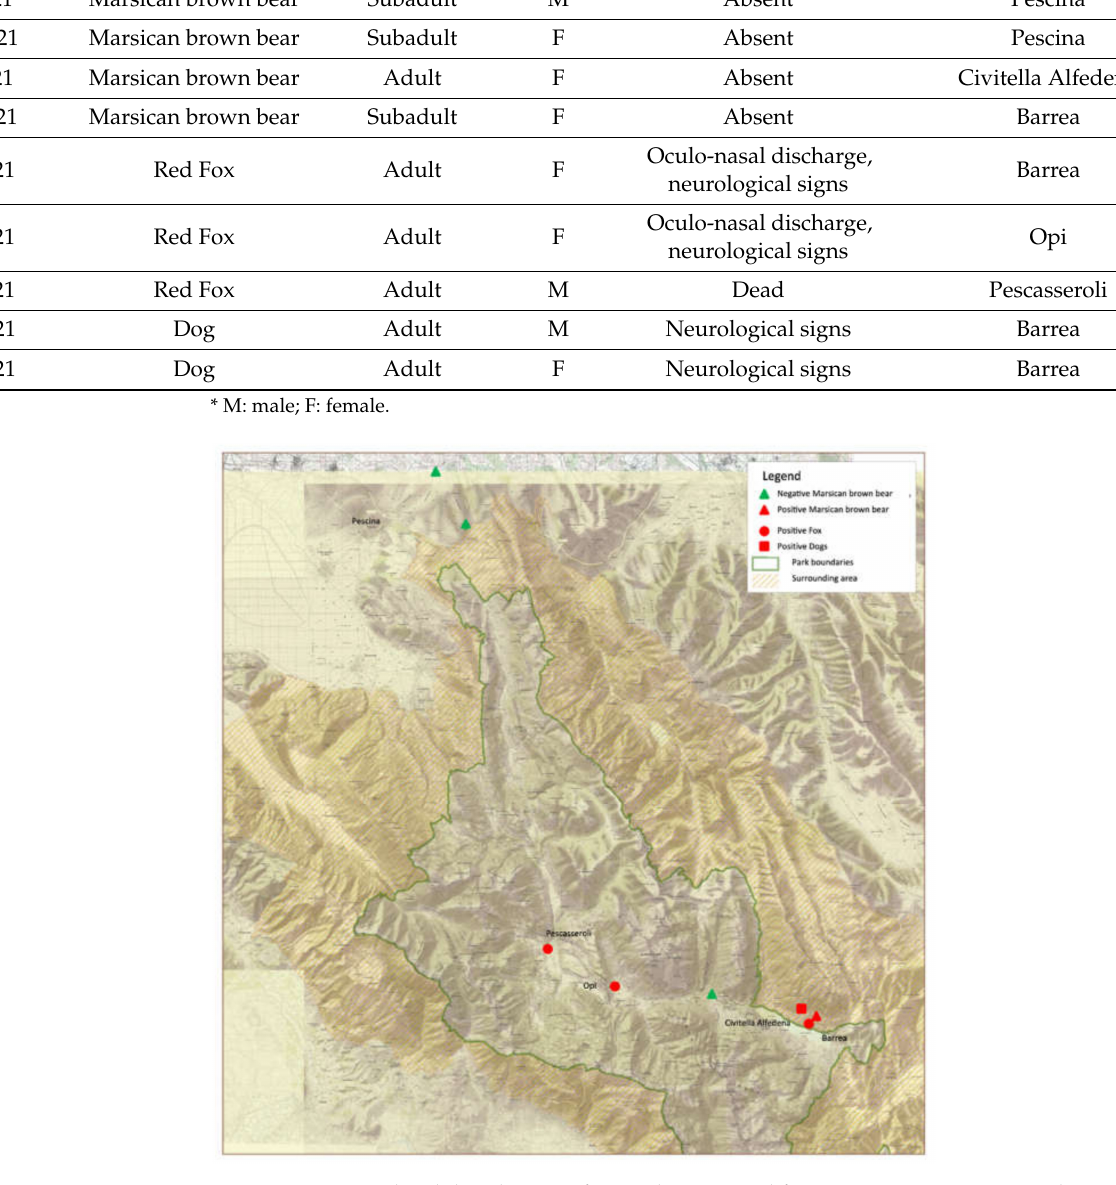
Figure 1. Geographical distribution of animals recovered from ALMNP territories and surrounding